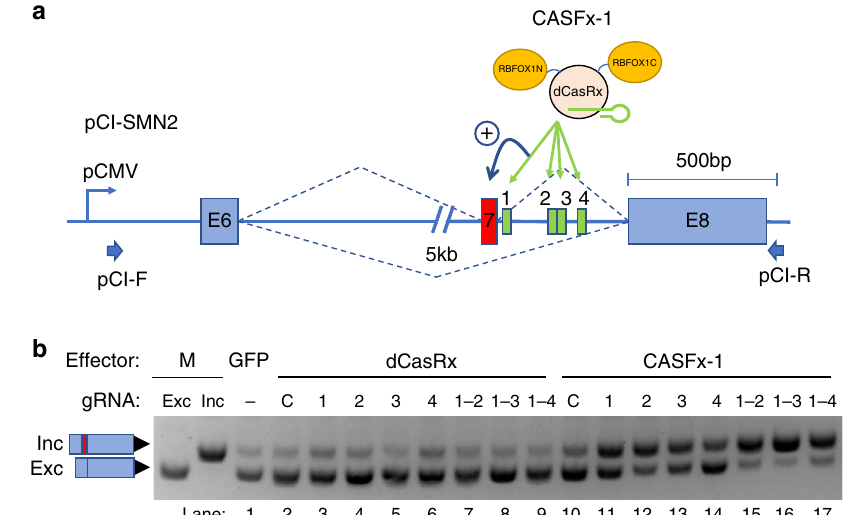
Fig. 1 Exon inclusion induced by CASFx-1 (RBFOX1N-dCasRx-C). a Schematic of the CASFx-1 and SMN2 minigene. The RNA binding domain of RBFOX1 was substituted by dCasRx to create an RNA-guided CRISPR Arti fi cial Splicing Factor 1 (CASFx-1) RBFOX1N-dCasRx-C. The SMN2 minigene on plasmid pCI-SMN2 contains exons 6 (E6) and 8 (E8) that are constitutively spliced, and exon 7 (E7) that is alternatively spliced, and the intervening introns, driven by the CMV promoter (pCMV). Four designed guide RNA (gRNA) target sites are indicated by numbered boxes 1 through 4 within the intron between E7 and E8. pCI-F and pCI-R indicate primers used for semi-quantitative RT-PCR assays. b Gel image of splicing RT-PCR using primers pCI-F and pCI-R on SMN2 minigene transcripts in cells co-transfected with control GFP plasmid (pmaxGFP), unfused dCasRx, or CASFx-1 (RBFOX1N-dCasRx-C), and the indicated gRNAs, numbers correspond to those in panel a with dash indicating the range of gRNAs used. “ C ” indicates a control gRNA not matching SMN2 minigene. Upper and lower bands correspond to the E7-included and -excluded transcripts, respectively. Reference splicing bands derived from E7- excluded sample (pCI-SMN2-MS2) and E7-included sample (pCI-SMN2-MS2 + MCP-RBFOX) 10 serve as molecular weight markers (M) for inclusion (Inc) and exclusion (Exc) events. The image shown is representative of two independent experiments. Uncropped gel images are included in the Source Data fi